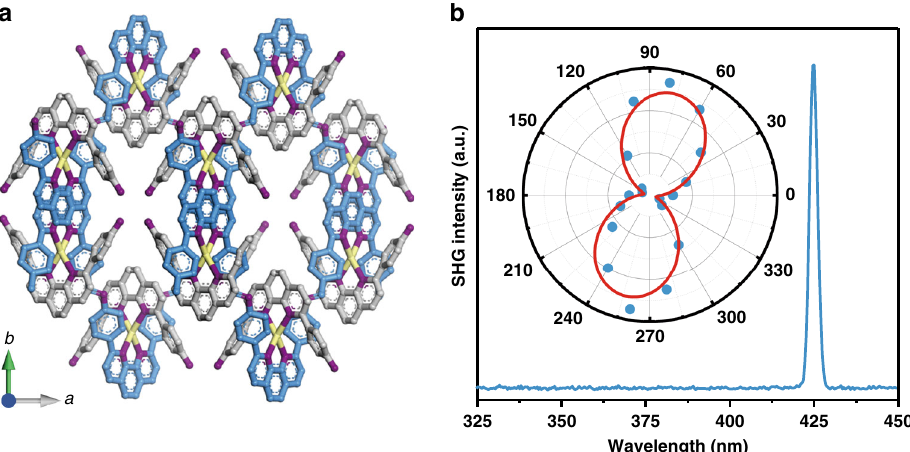
Fig. 3 Single-crystal structure and nonlinear optical measurements of mCOF-Ag. a Crystal view of mCOF-Ag along the c -axis. Colour scheme: C on organic chains, blue; C on pendants, grey; N, purple; Ag, yellow. Hydrogen atoms and BF 4 ‾ anions are omitted for clarity. b The SHG spectrum of an isolated crystal of mCOF-Ag. The excitation wavelength is 850 nm, the peak at 425 nm is the SHG signal. Inset: polarisation dependent SHG response. Red curve is the fi tting result of experimental data (blue dots). The units are in